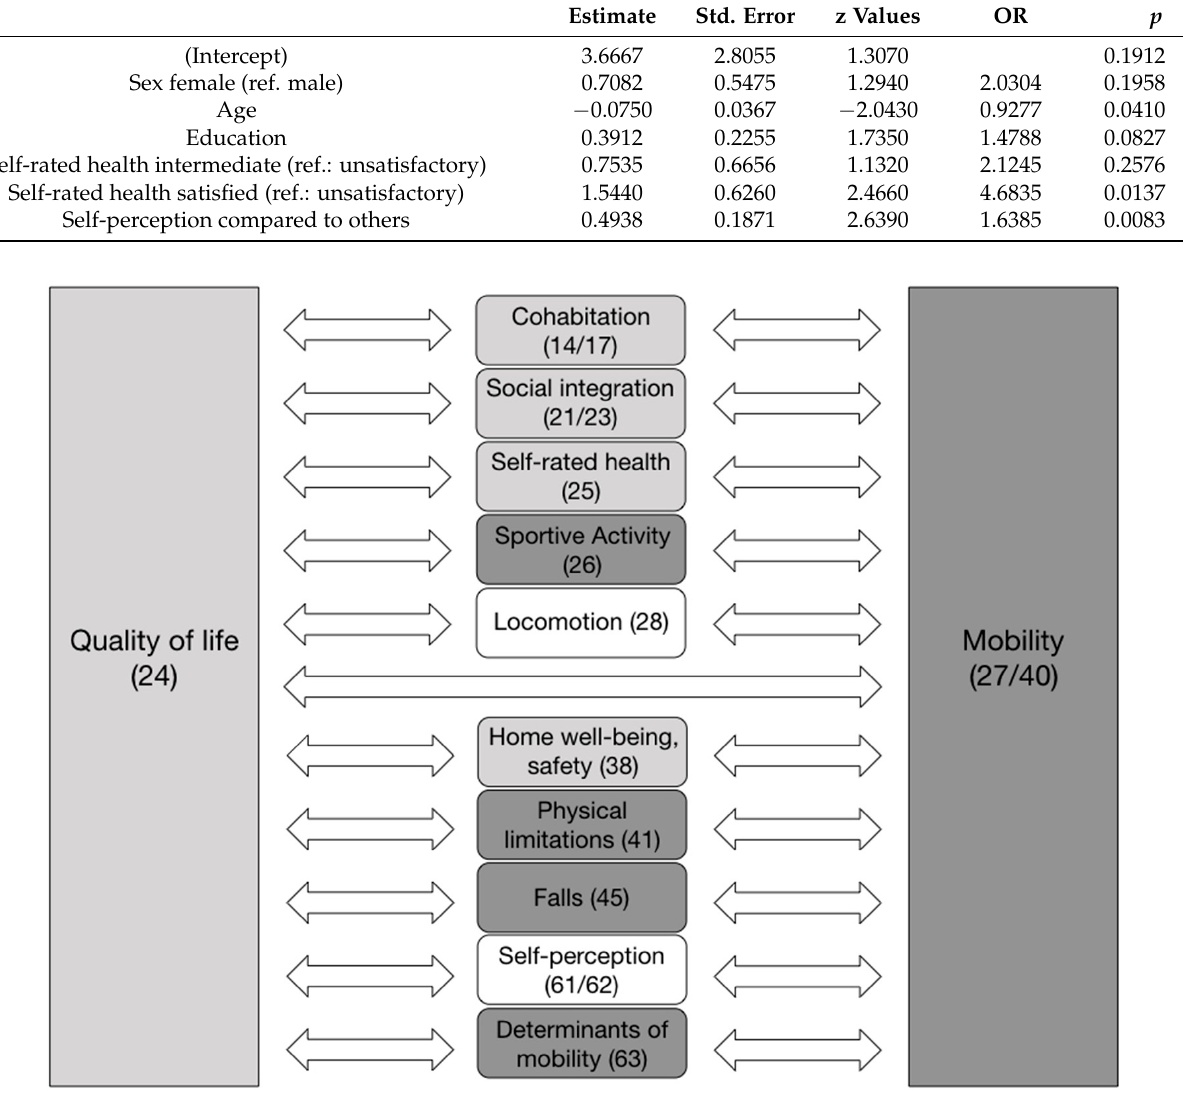
Figure 1. Representation of the independent variables “Quality of life” and “Mobility” and their possible associations with the dependent variables (the number of the relevant question is given in brackets).